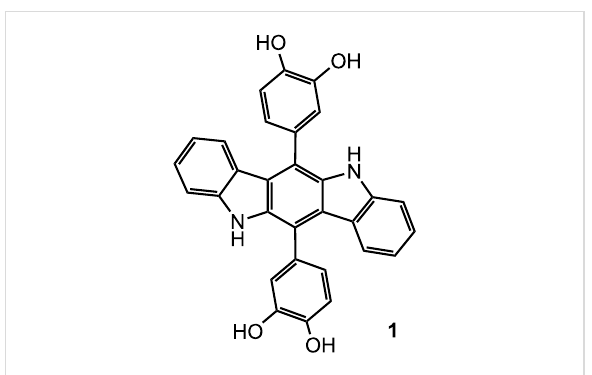
Figure 1: The structure of the indolocarbazole-based chemosensor 1 .